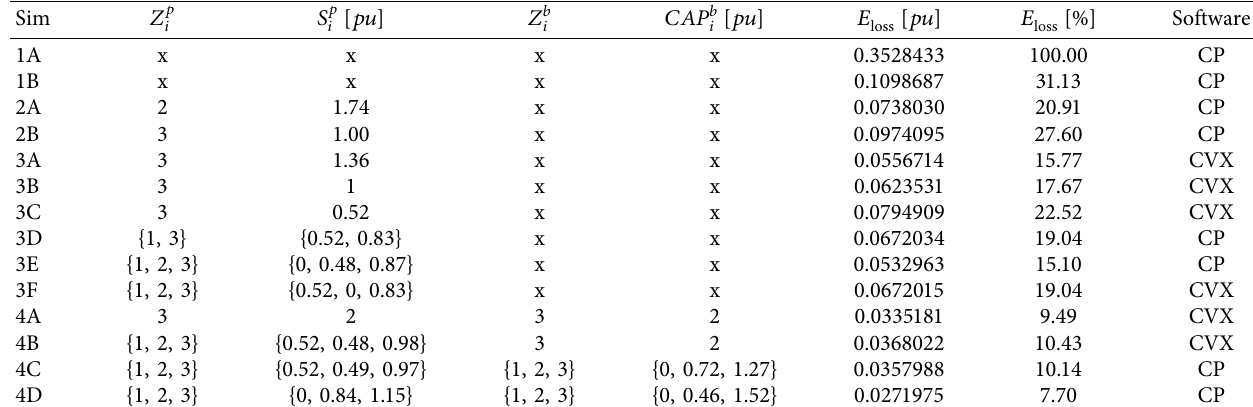
Table 3: Overview simulation results from 1A to 4D.